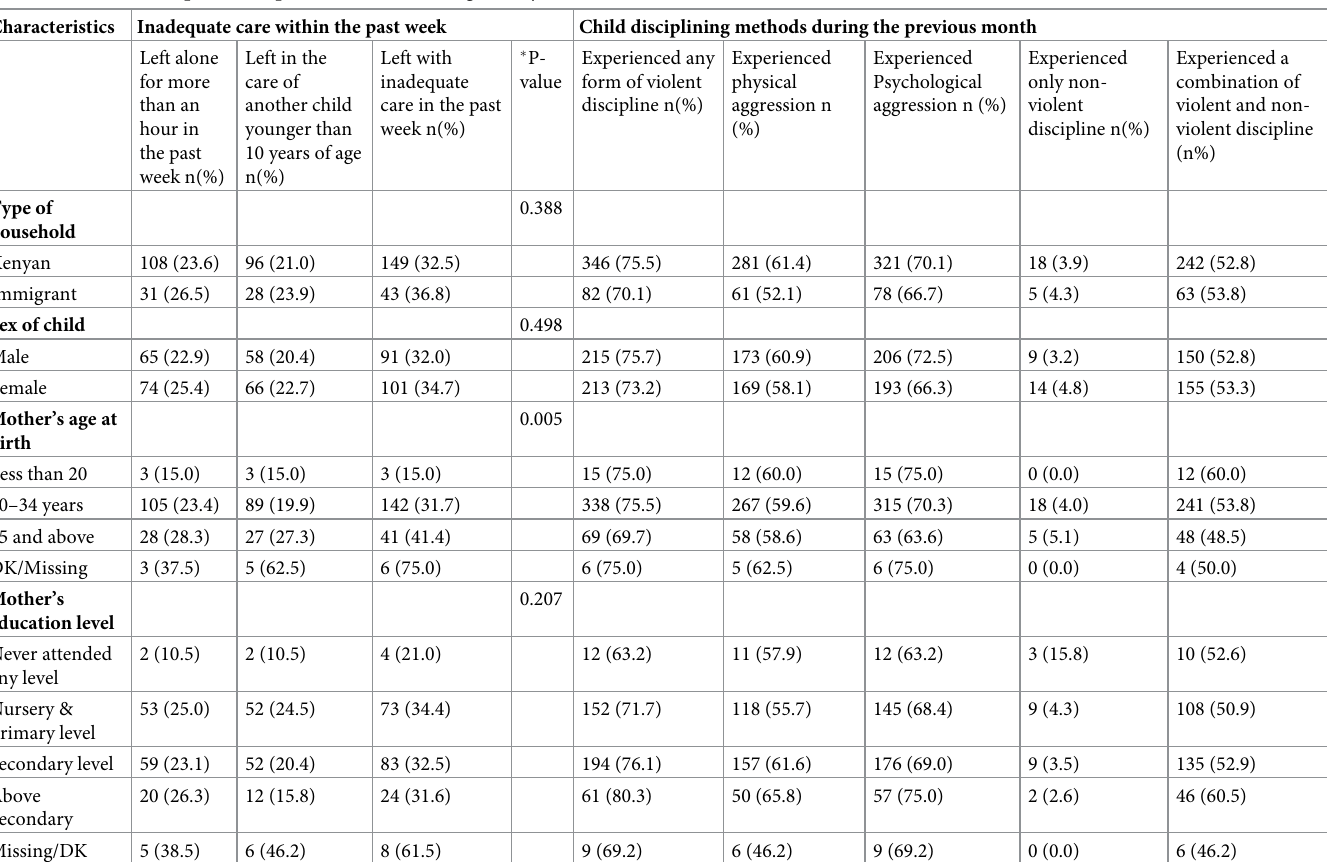
Table 7. Childcare and protection practices for children ages 0–2 years. Characteristics Inadequate care within the past